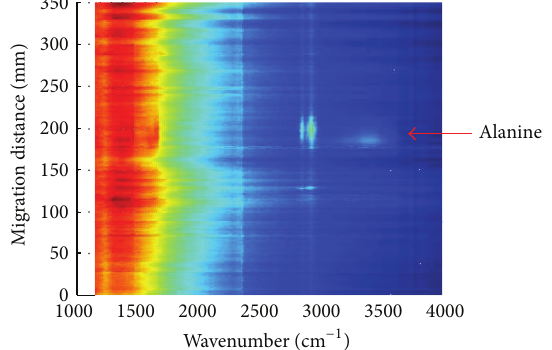
Figure 2: 3D chromatograph to locate the alanine spot on the narrow band TLC plate.